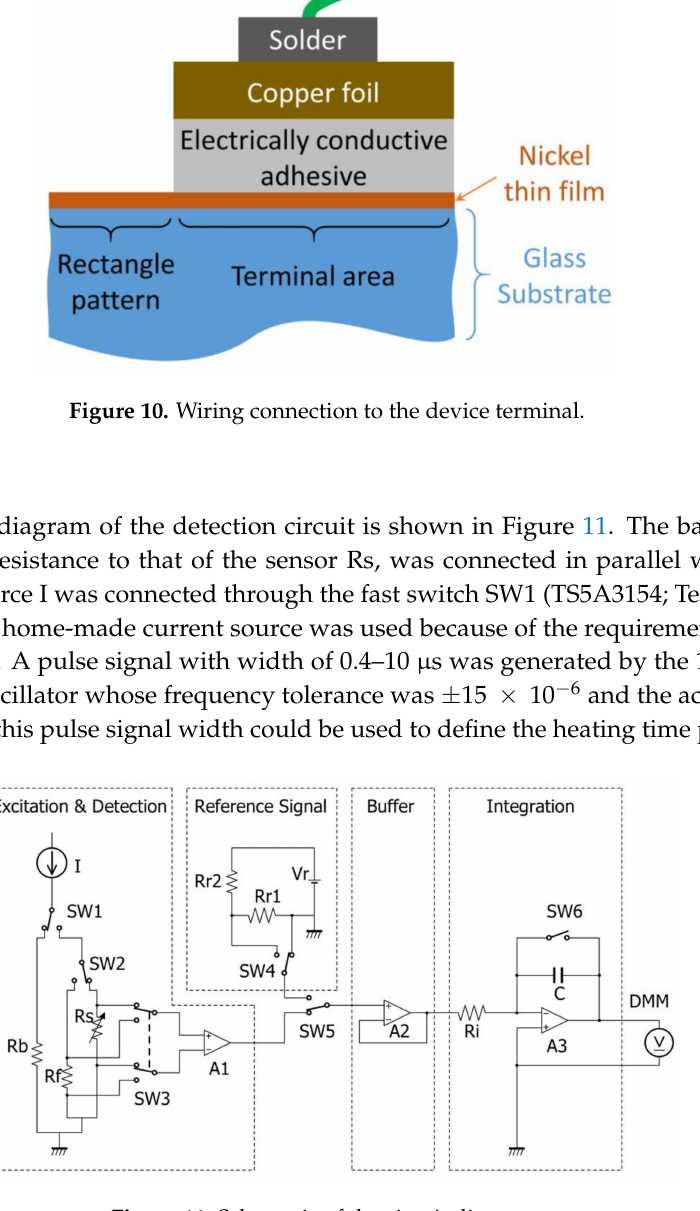
Figure 11. Schematic of the circuit